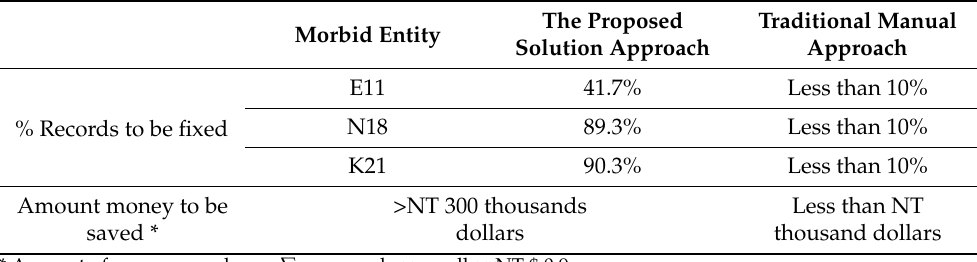
Table 4. The comparison of the proposed solution approach to traditional manual